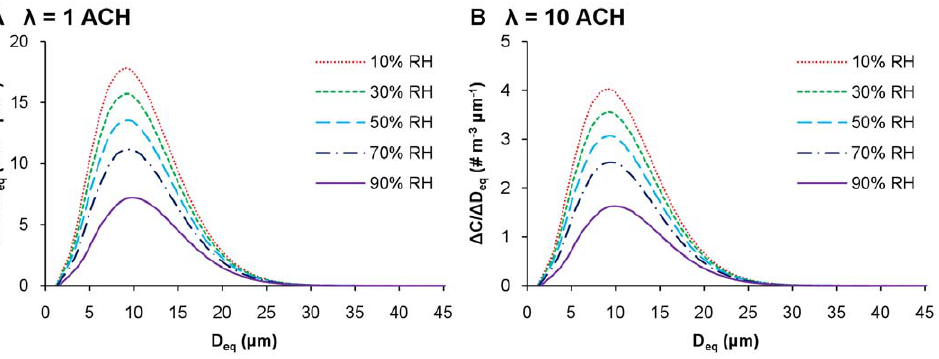
Figure 4. IAV size distributions. Infectious IAV size distributions at various RHs in residential (A) and public (B) settings with a volume of 50 m 3 and a height of 2.5 m, 10 min after a cough.